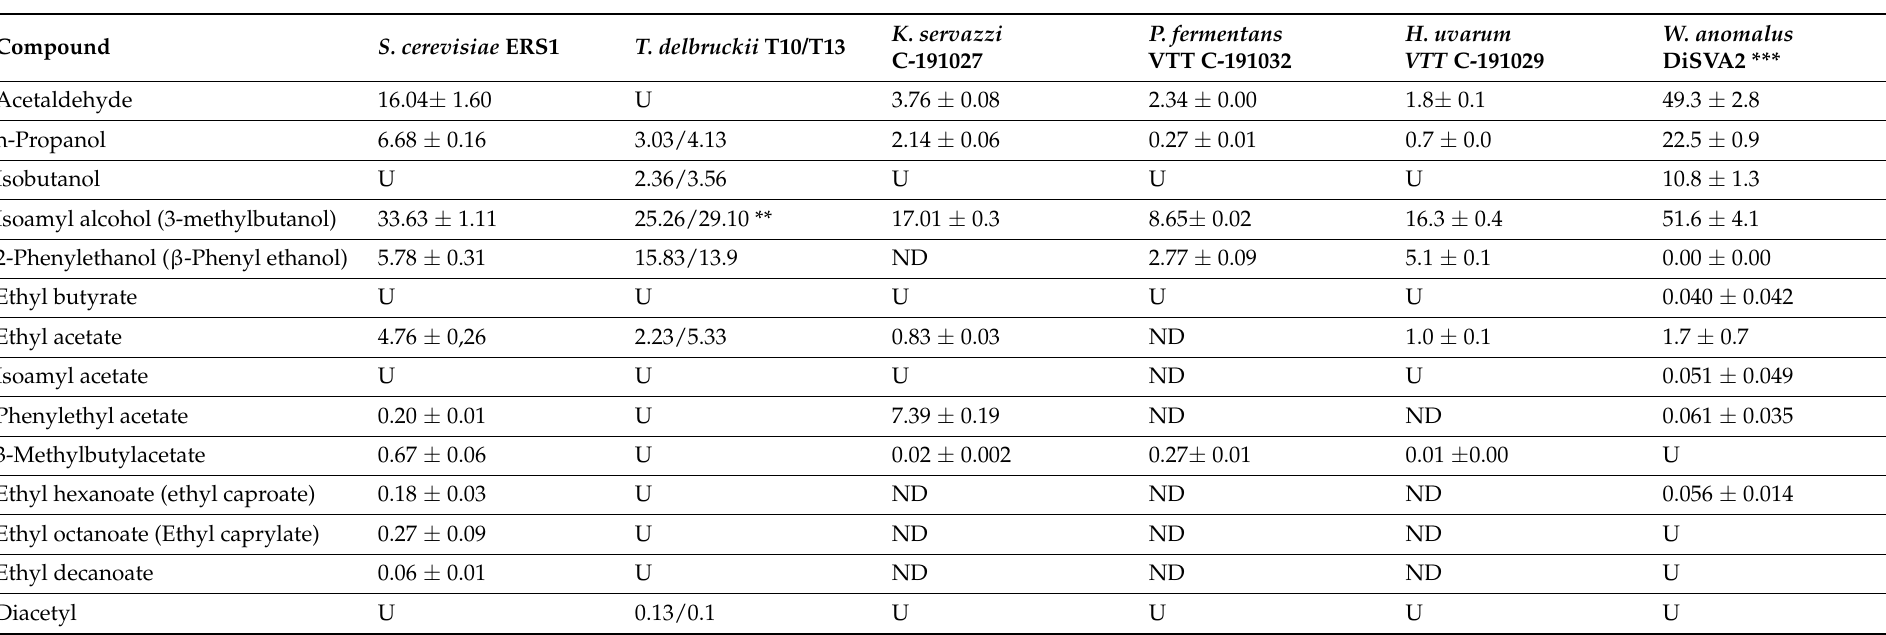
Table 5. Comparison of selected volatile compounds in NABLAB beers produced with some maltose-negative yeasts for the production of special beer types